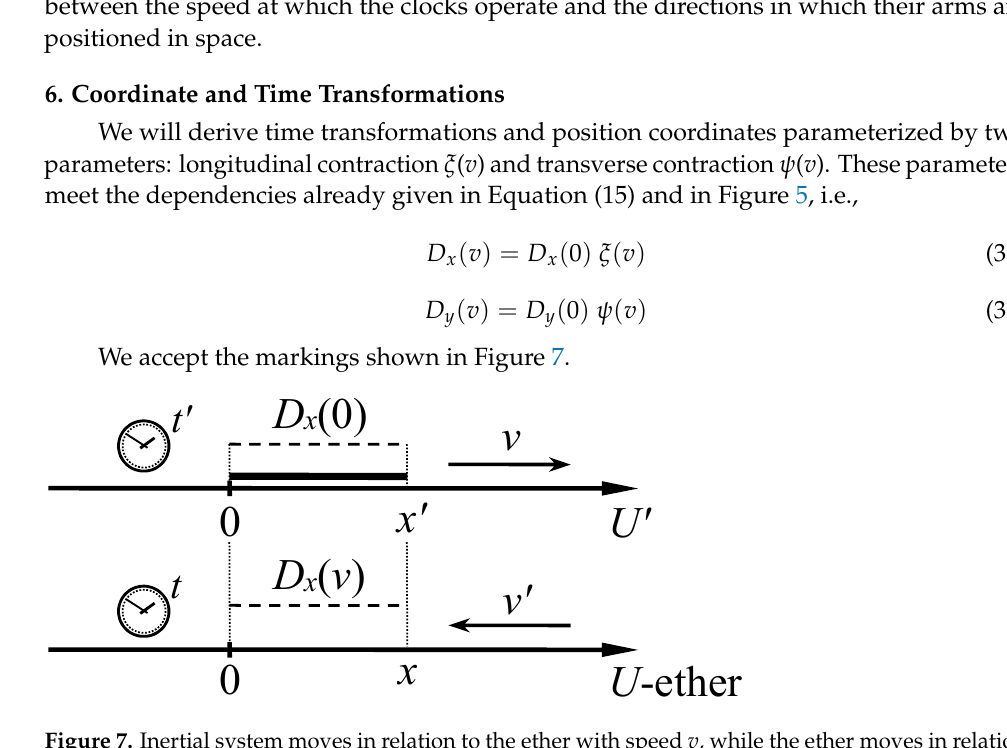
Figure 7. Inertial system moves in relation to the ether with speed v , while the ether moves in relation to the inertial system with speed v ′ ( v ⋅ v ′ ≤ 0).